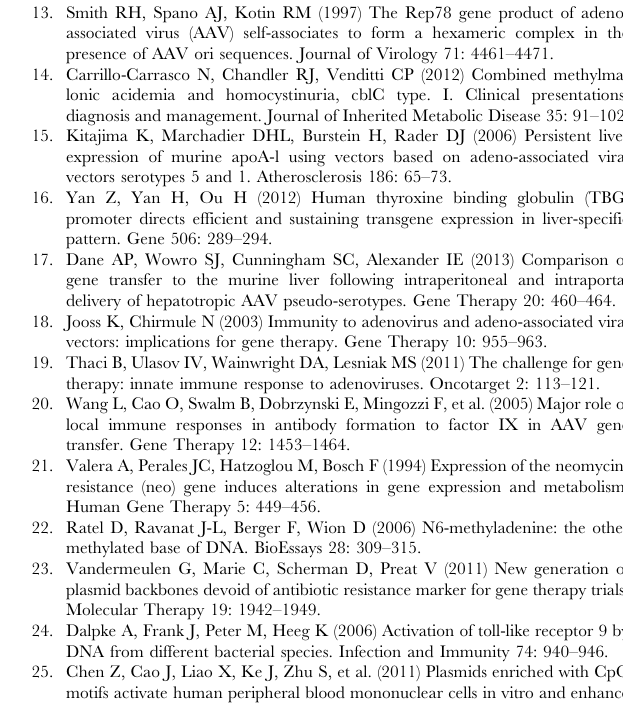
tandem head-to-tail configuration would produce x + y fragments, which were not detected. (TIF) Figure S2 Anti-Rep protein western blot of CELiD-GFP DNA samples treated with Serratia marcescens endonu- clease. CELiD-GFP DNA samples were treated with 6.7 units of S. marcescens endonuclease (Turbonuclease, Accelegen, Inc., San Diego, CA, USA) (except for the material in lane 5, which was treated with 26.8 units) at 37 u C for 30 min prior to SDS- polyacrylamide gel electrophoresis (SDS-PAGE) and western blotting. The quantities of CELiD-GFP DNA treated